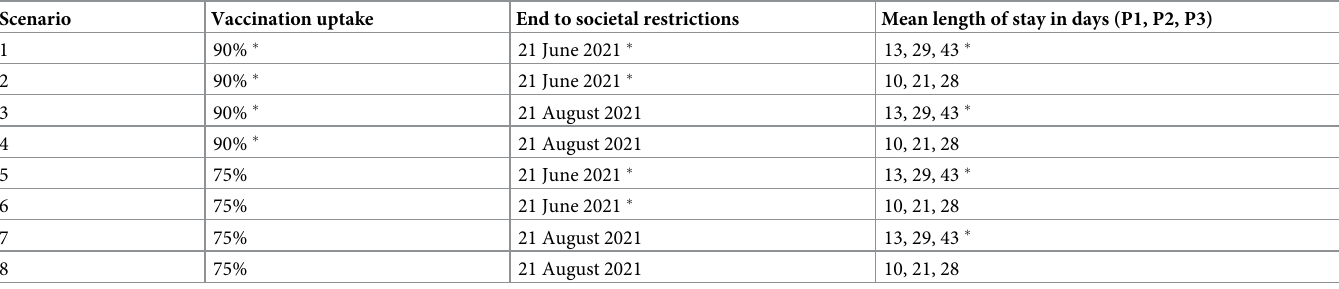
Table 1. Scenarios considered in this study, with baseline values are indicated by ( � ).